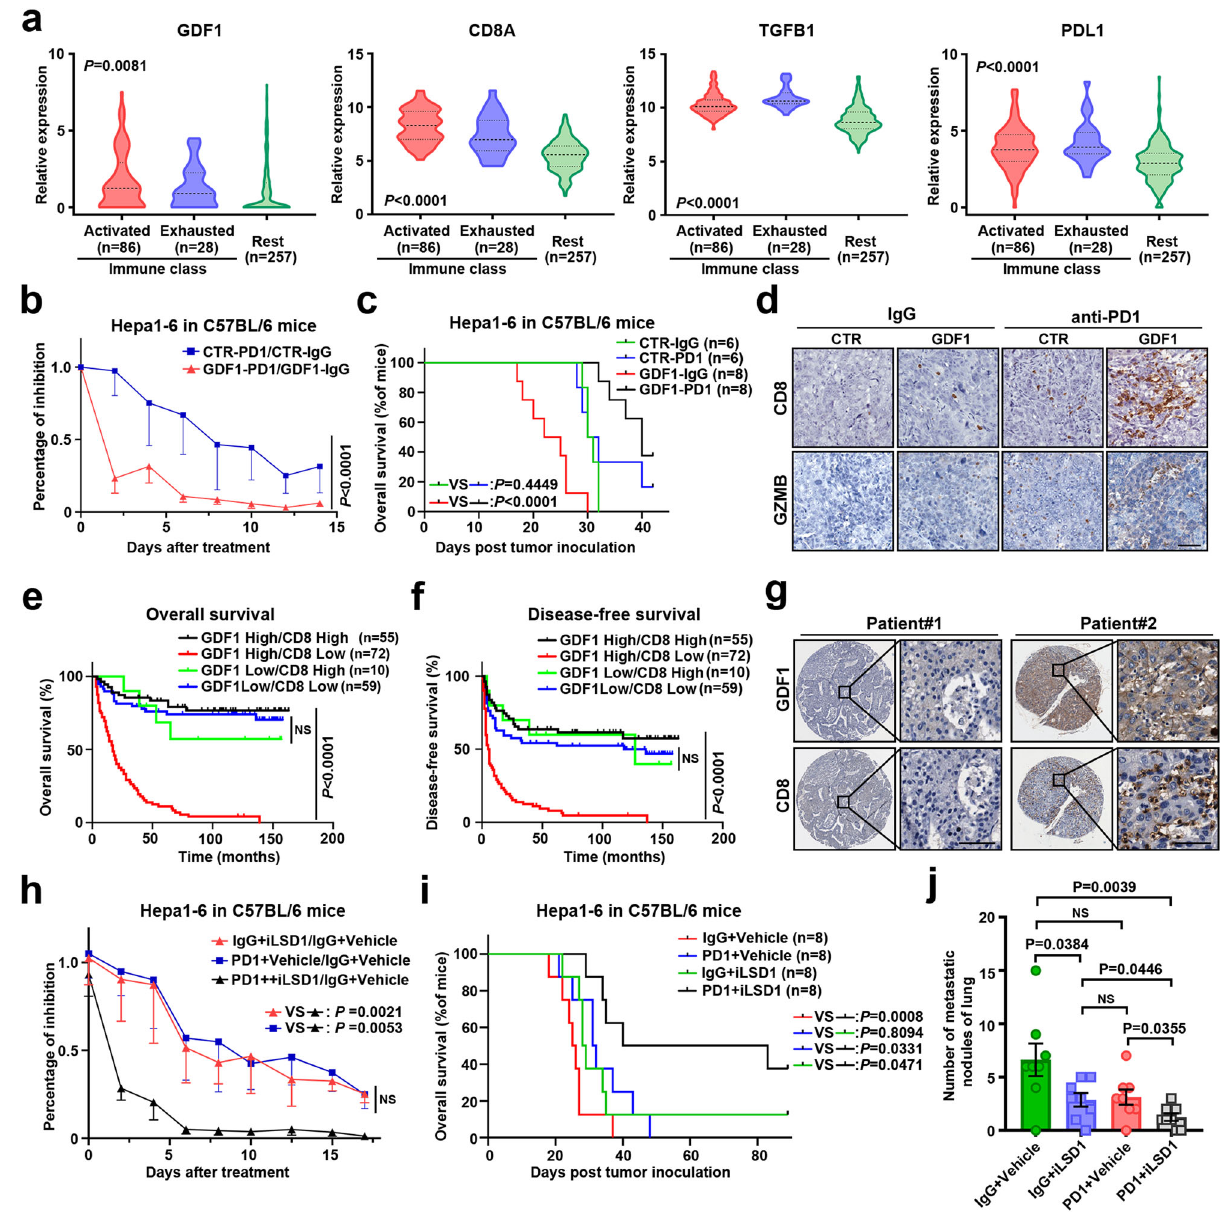
Fig. 6 GDF1-induced tumour-lineage plasticity might sensitise HCC patients to anti-PD1 therapy. a HCC patients from the TCGA – LIHC project were divided into three subgroups according to the speci fi ed classi fi ers. The relative expression of GDF1, CD8A, TGFB1, and PDL1 was shown in different subgroups of patients (one-way ANOVA test). b C57BL/6 mice bearing Hepa1 – 6 tumours transfected with mGDF1 or control vector were treated with anti-PD1 antibodies or control IgG at 100 μ g/mouse every three days. The tumour-inhibition rates were detected by an in vivo bioluminescence imaging system (two-way ANOVA test, data are presented as mean values ± SEM, CTR-IgG: n = 6, CTR-PD1: n = 6, GDF1-IgG: n = 8, GDF1-PD1: n = 8). c Kaplan – Meier analysis of overall survival in C57BL/6 mice bearing Hepa1-6 tumours transfected with mGDF1 or control vector and treated with anti-PD1 antibodies or control IgG (log-rank test). d IHC staining of CD8 and GZMB in mouse orthotopic Hepa1 – 6 tumours transfected with mGDF1 or control vector and treated with anti-PD1 antibodies or control IgG. Scale bars represent 50 µ m, n = 3 independent experiments. e, f IHC staining of GDF1 and CD8 + in fi ltrating T lymphocytes was performed in consecutive TMA slides. Kaplan – Meier analysis of overall survival ( e ) and disease-free survival ( f ) in HCC patients divided into four subgroups according to GDF1 and CD8 staining (NS, not signi fi cant, log-rank test). g Representative IHC staining of GDF1 and CD8 in consecutive TMA slides with 196 liver tumour tissues. Scale bars represent 50 µ m. IgG, immunoglobulin G. PD1, anti-PD1 antibody. h C57BL/6 mice bearing Hepa1 – 6-CTR or Hepa1 – 6-GDF1 KO cells were treated with LSD1 inhibitor, anti-PD1 antibody, or combination of both. For treatment with antibody, tumour-bearing mice were treated with anti-PD1 antibodies or control IgG at 100 μ g/mouse every three days. For LSD1 inhibitor treatment, tumour-bearing mice were treated with 10 mg/kg of GSK-LSD1 or vehicle (4% DMSO in saline) each week (4 consecutive days followed by a 3-day holiday). The tumour inhibition rates were detected by an in vivo bioluminescence imaging system (NS, not signi fi cant, two-way ANOVA test, data are presented as mean values ± SEM, n = 8 mice per group). i Kaplan – Meier analysis of overall survival in C57BL/6 mice bearing Hepa1 – 6 tumours with different treatment groups (log-rank test). j The number of metastatic lung nodules in mice bearing Hepa1 – 6 tumours with different treatment groups. (NS, not signi fi cant, two-tailed independent Student ’ s t -test, data are presented as mean values ± SEM, n = 8 mice per group). Source data are provided as a Source Data fi